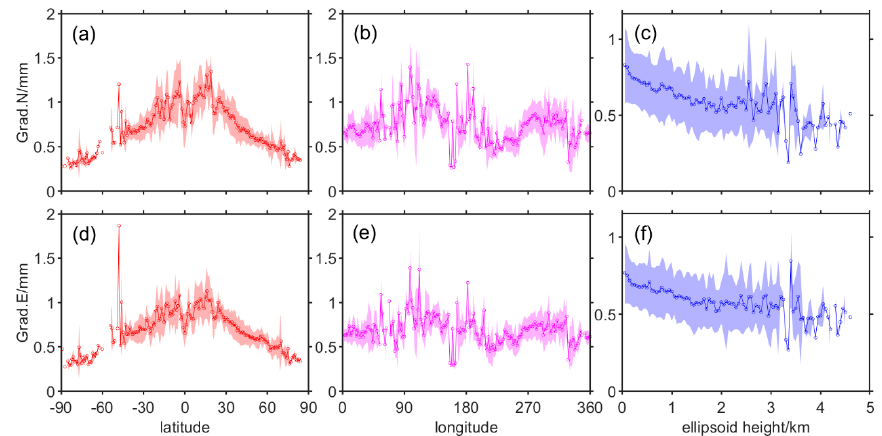
Figure 5. The relationship between Grad.N and Grad.E root mean square (RMS) values with ( b , e ), latitude ( a , d ) and ellipsoid height ( c , f longitude ( b , e ), latitude ( a , d ) and ellipsoid height ( c , f ).